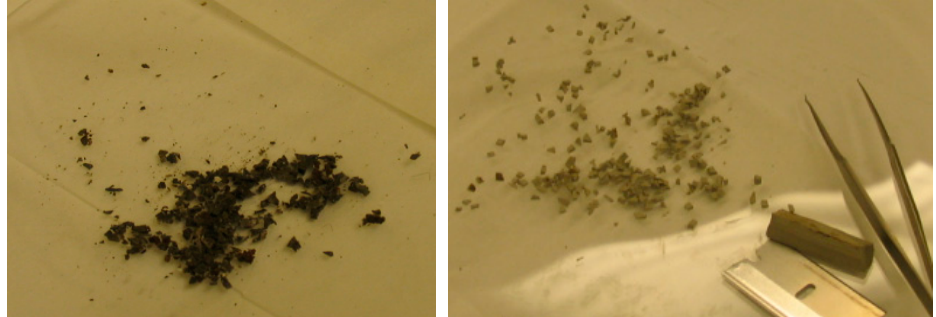
Figure 1. Caulk and glazing materials reduced to smaller particles using a disposable razor blade or scissors. or